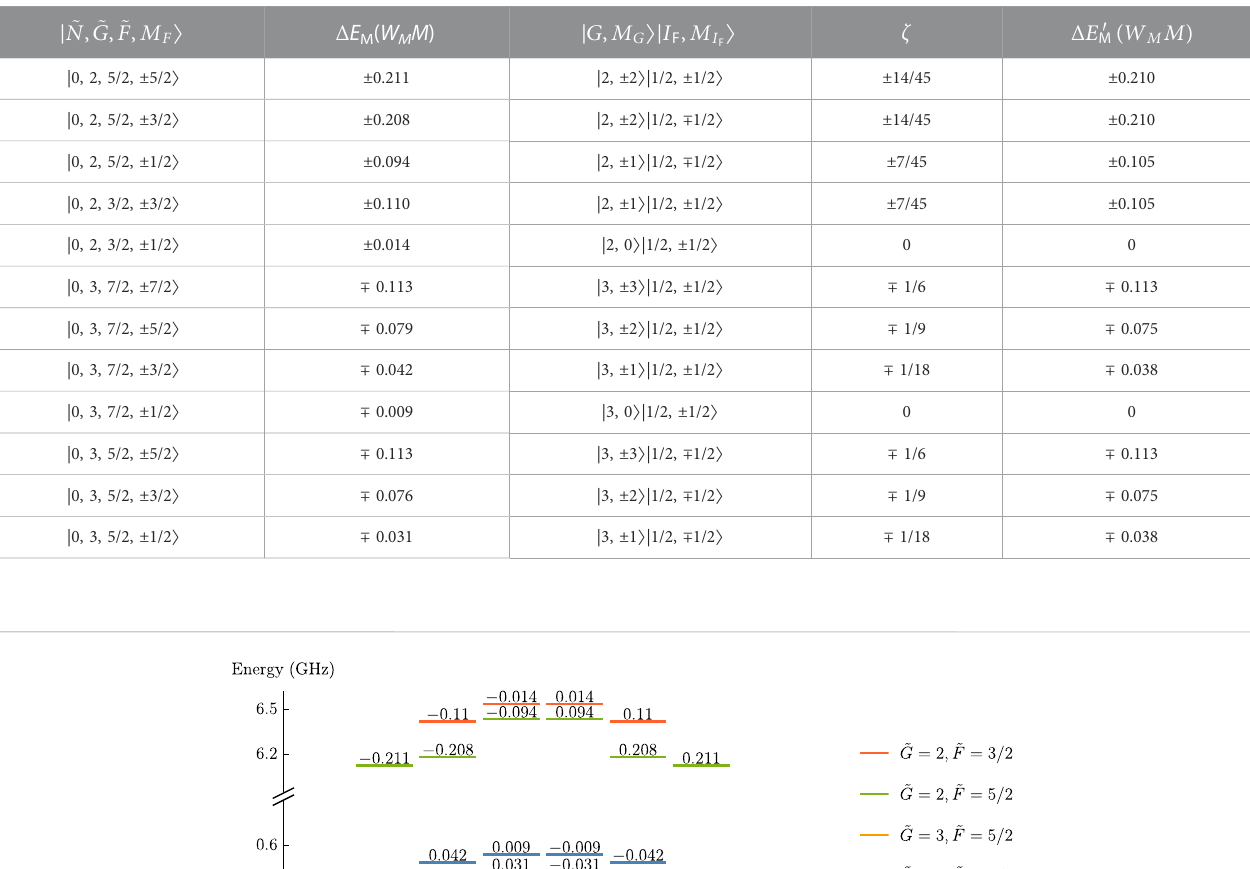
TABLE 2 MQM energy shifts for states correlating to the lowest rotational level of 173 YbF, in an electric fi eld of 18 kV/cm. We have dropped ~ F 1 from the state notation since ~ F 1 (cid:1) ~ G for these states. The second column gives Δ E M calculated using Eq. 6. The fourth column gives ζ calculated using Eq. A6 and the fi fth column gives Δ E M 9 calculated using Eq. 4.